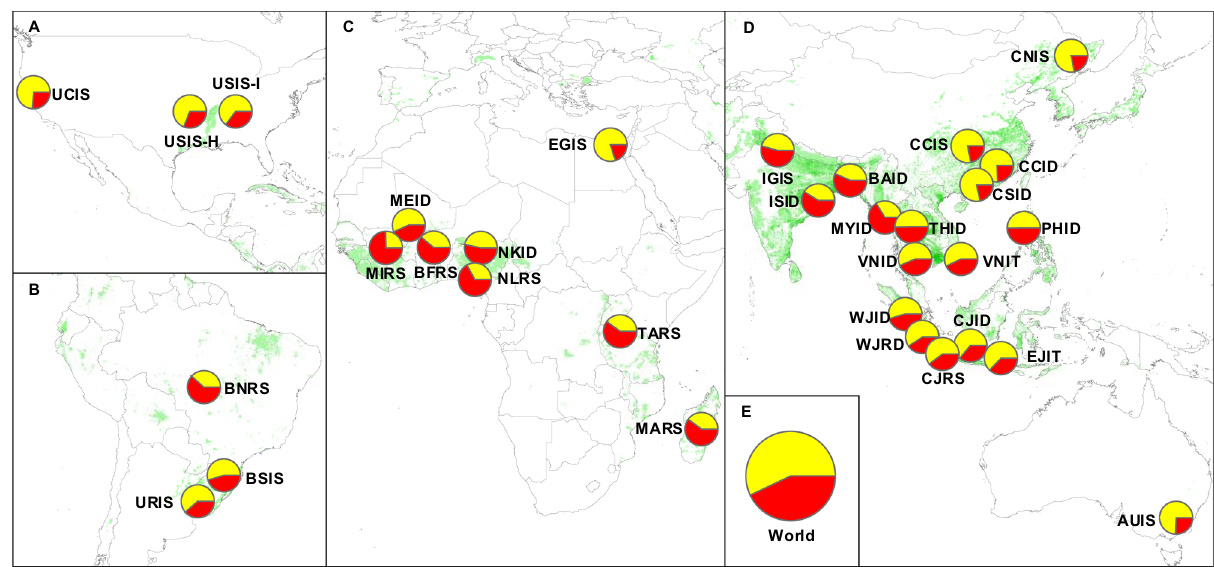
Fig. 1 Map showing the rice systems assessed in this study and their associated yield gap (red portions of pie charts) and actual yield (yellow portions of pie charts) expressed as percentage of the yield potential. Panels correspond to A North America, B South America, C Africa, D Asia and Australia, and E world. Rice area distribution is shown in green (SPAM maps 77 ). Cropping system code consists of region ( fi rst two letters), water regime (third letter), and rice cropping intensity (fourth letter). Regions: Australia (AU); Bangladesh (BA); northern and southern Brazil (BN and BS, respectively); Burkina Faso (BF); central, northern, and southern China (CC, CN, and CS, respectively); Egypt (EG); Indo-Gangetic Plains and southern India (IG and IS, respectively); central, east, and west Java, Indonesia (CJ, EJ, and WJ, respectively); Madagascar (MA); Segou and Sikasso, Mali (ME and MI);